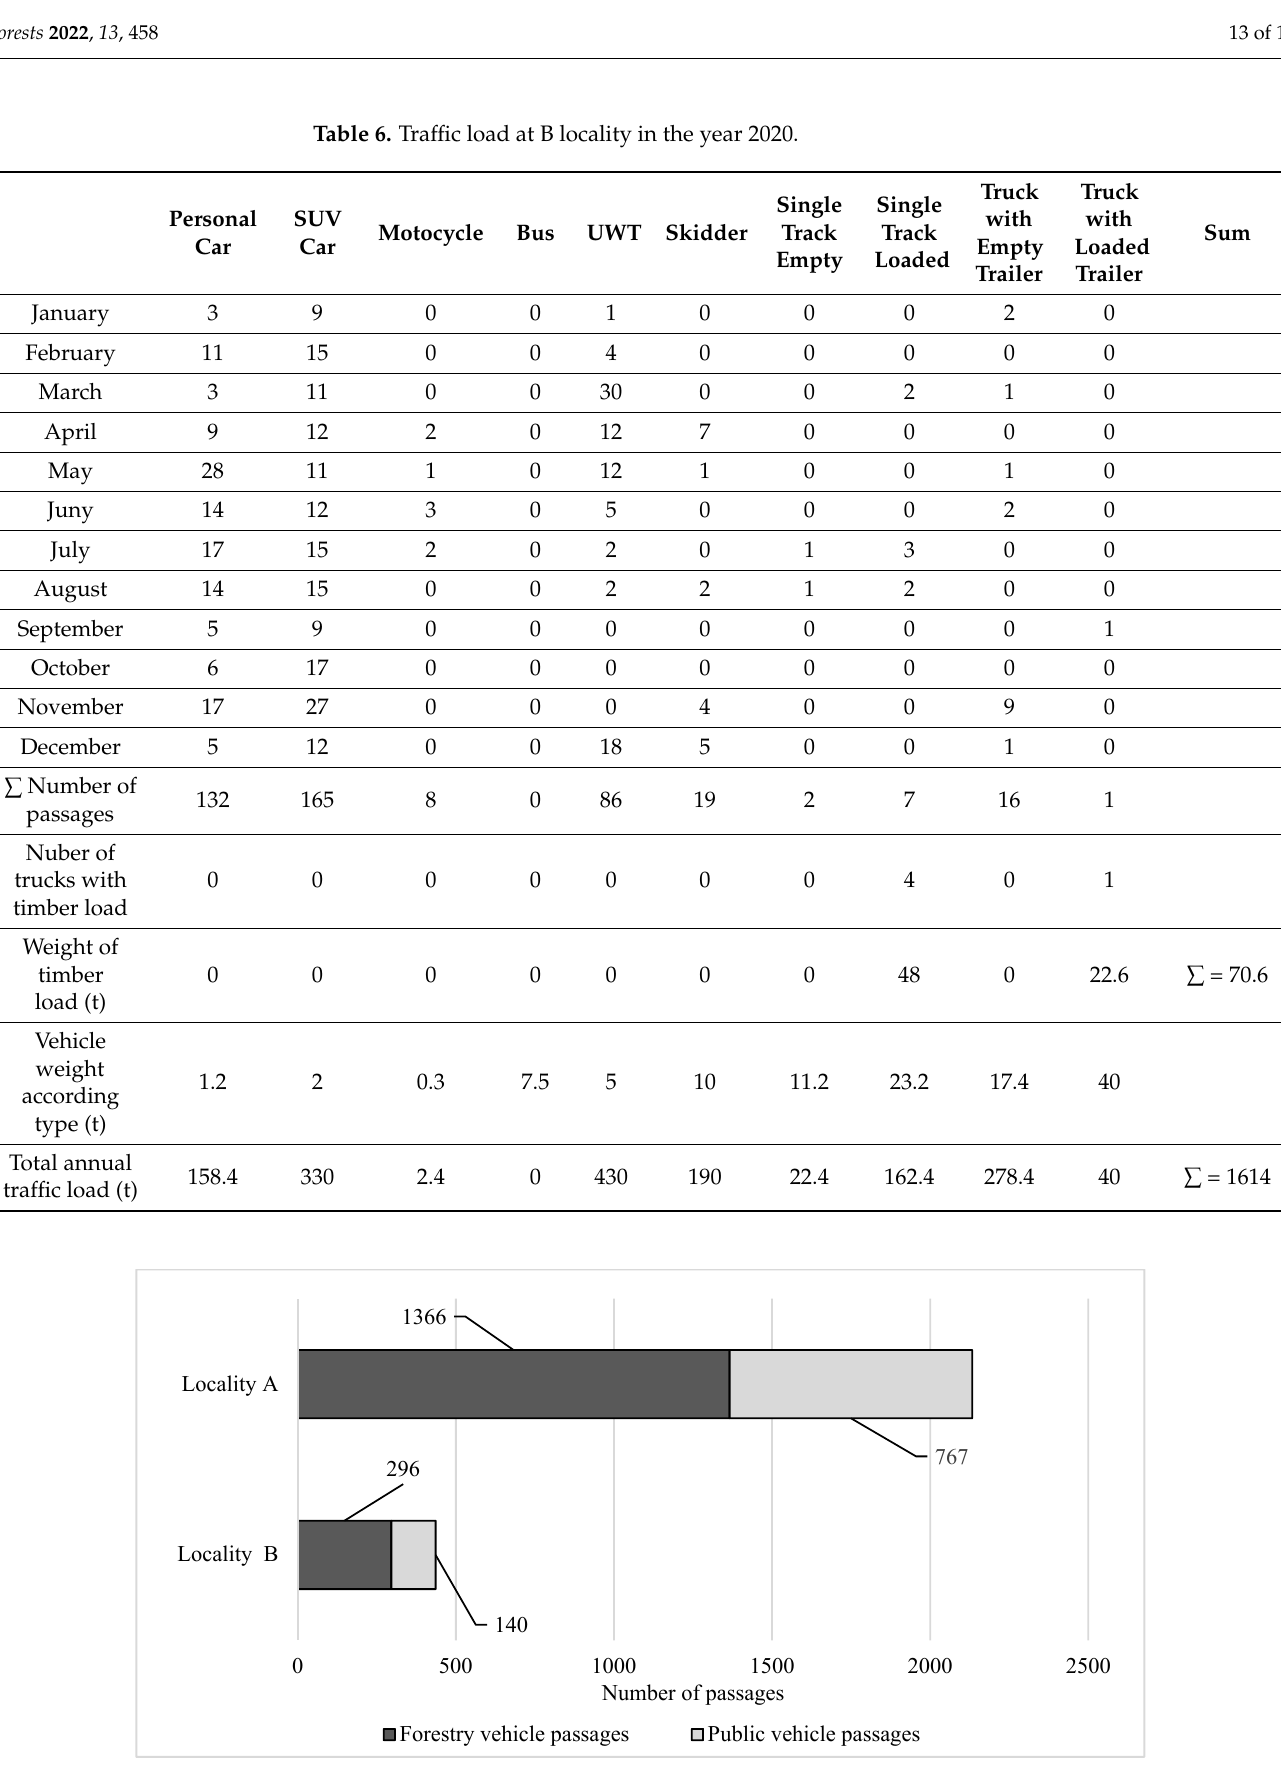
Figure 8. Comparison of annual numbers of passages of forestry practice and public.